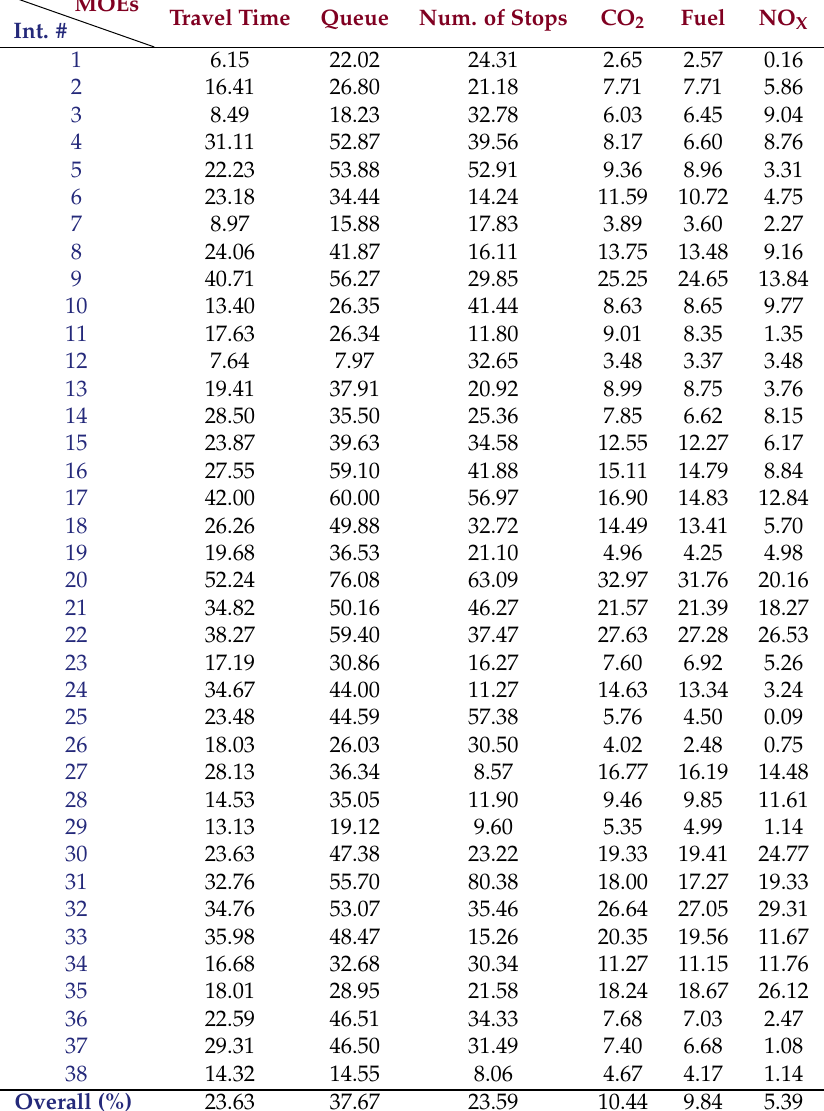
Table 7. Intersections (%) improvement of MOEs using DNB over PSC